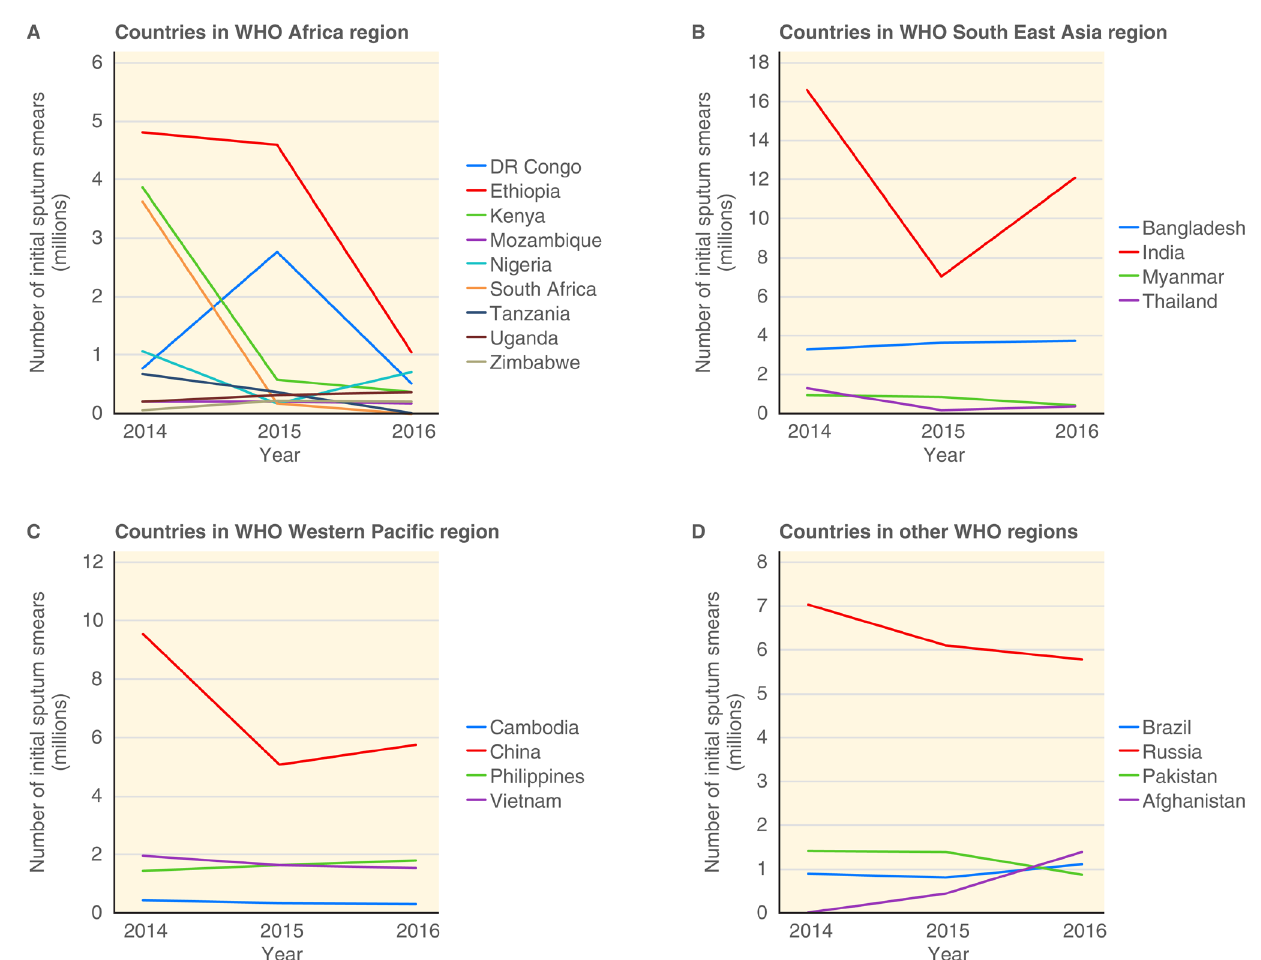
Figure 2. Initial sputum smear microscopy use in World Health Organization (WHO) regions from